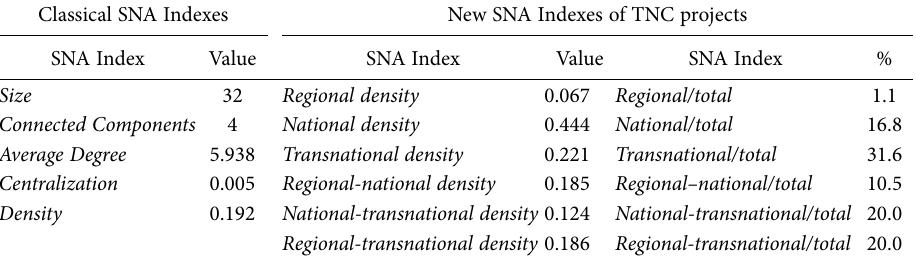
Table 7. Indexes of the transnational cooperation network of Veneto LAGs, LEADER +. Classical SNA